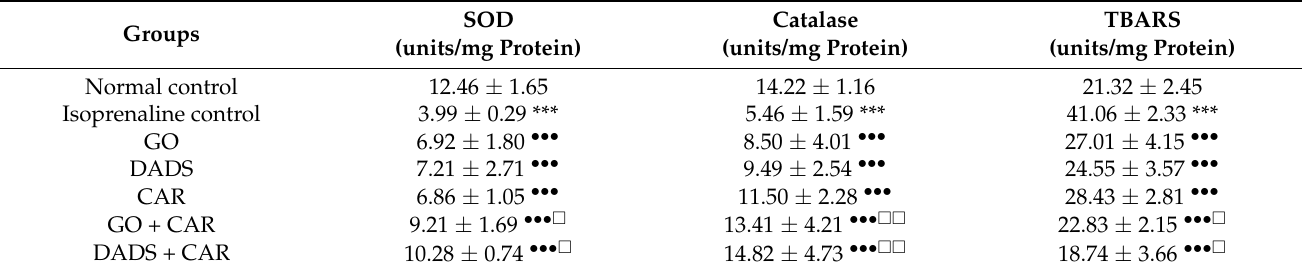
Table 3. Effect on cardiac antioxidants and lipid peroxidation product.